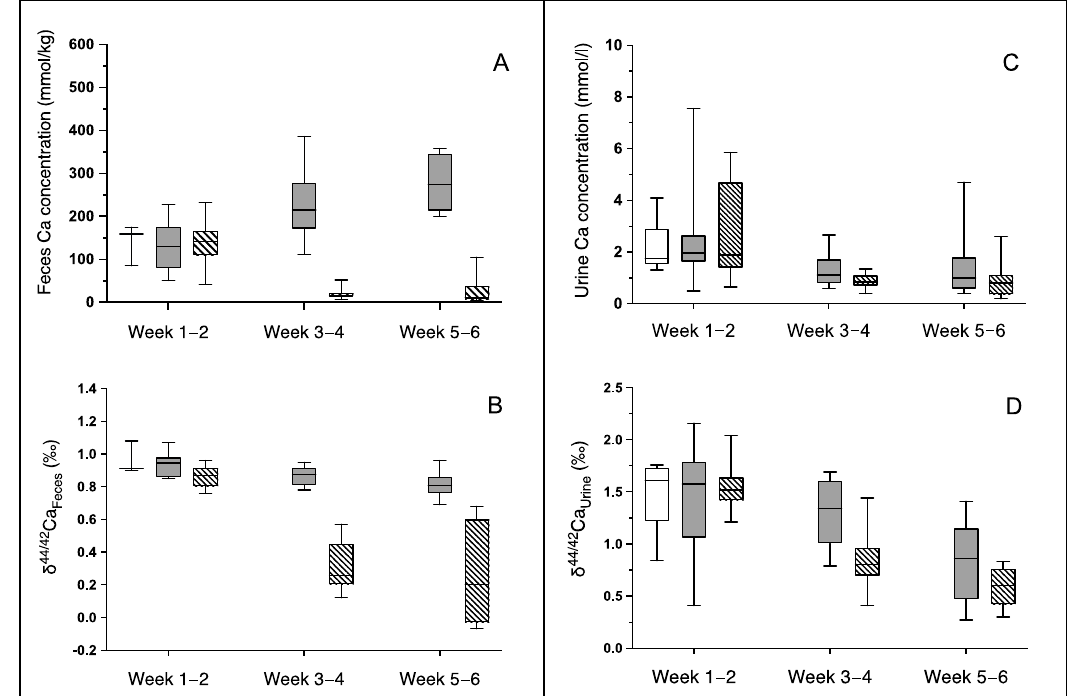
Figure 2. Fecal and urine Ca concentrations, δ 44/42 Ca Feces and δ 44/42 Ca Urine in rats after two weeks on standard-diet (empty boxes) and subsequent four weeks on standard- (gray boxes) and low-Ca-diet (hatched boxes). Fecal Ca concentrations ( A ) and δ 44/42 Ca Feces ( B ) were lower in animals on low-Ca-diet than in animals on standard-diet ( p = 0.005 and p < 0.0001). Urine Ca concentrations ( C ) and δ 44/42 Ca Urine ( D ) were lower in animals on low-Ca-diet (ANOVA, p = 0.03 and p < 0.0001). Relatively more heavy Ca isotopes were absorbed in the intestine and the renal tubular system in low-Ca-diet rats. Table 4. δ 44/42 Ca Bone of the femora and the lowest ribs (1) and of the left tibia epiphysis, metaphysis and diaphysis (2) of rats after two weeks on standard-diet (group 1, 0.5% Ca) followed by four weeks of standard-Ca-diet (group 2, 0.5% Ca) or low-Ca-diet (group 3, 0.25%